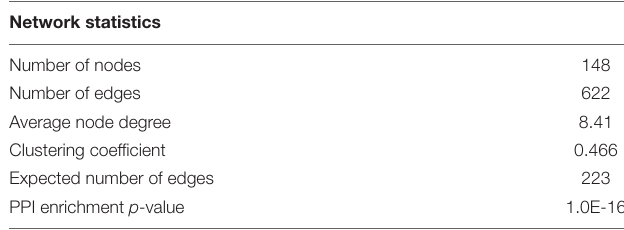
TABLE 4 | Network statistics of immune-related proteins.